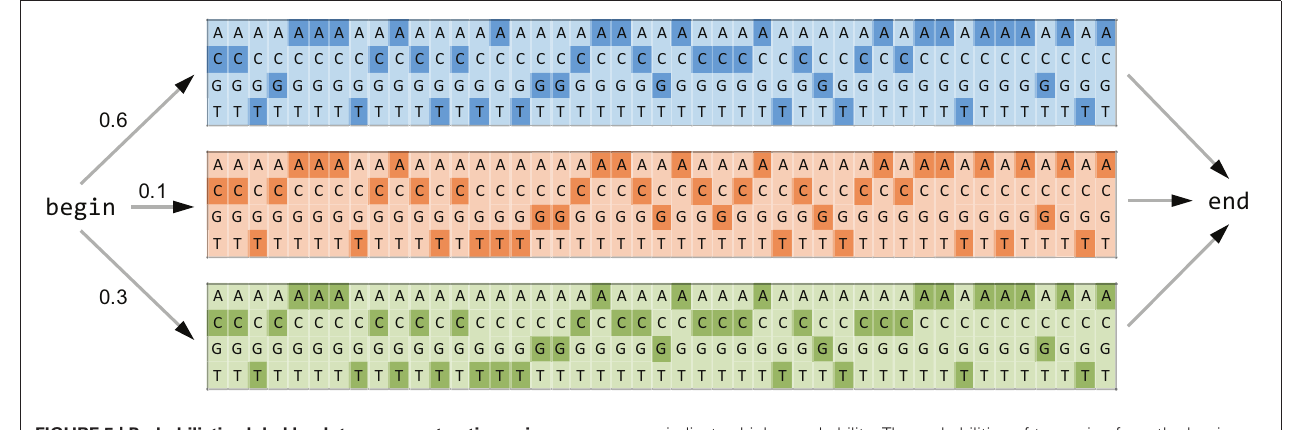
indicates higher probability. The probabilities of traversing from the begin node to one of the haplotypes serve as an estimate for the haplotype frequencies. Each read is regarded as an independent observation from this statistical model.